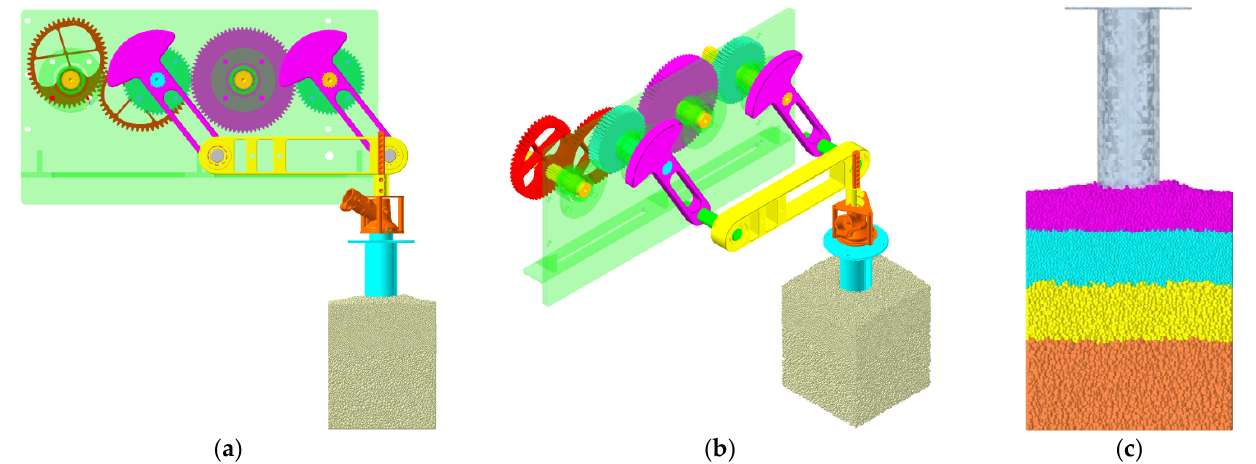
Figure 3. Bidirectional coupling model of Recurdyn–EDEM for the cavitating mechanism: ( a ) front view of model in Recurdyn; ( b ) axonometric drawing of bidirectional coupling model; ( c ) bidirectional coupling model in EDEM.